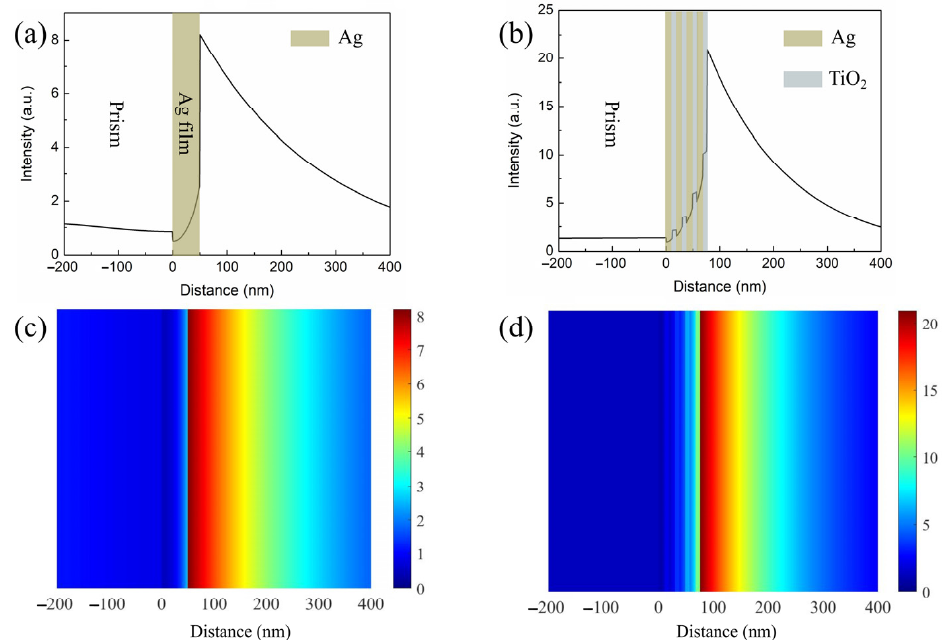
Figure 4. Electric field distributions for ( a ) conventional sensor based on single Ag film, ( b ) the proposed sensor. Two dimensional plots of electric field distribution for ( c ) conventional Ag-based sensor, ( d ) the proposed sensor.